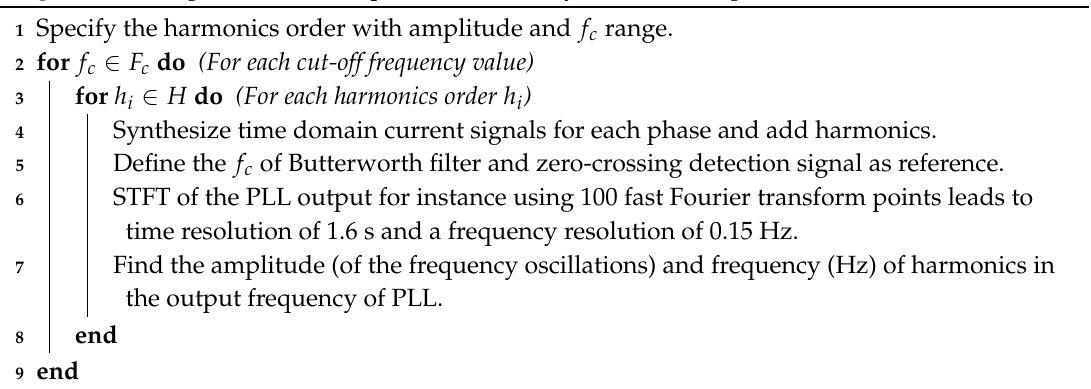
Algorithm 1: Algorithm for PLL performance analysis considering